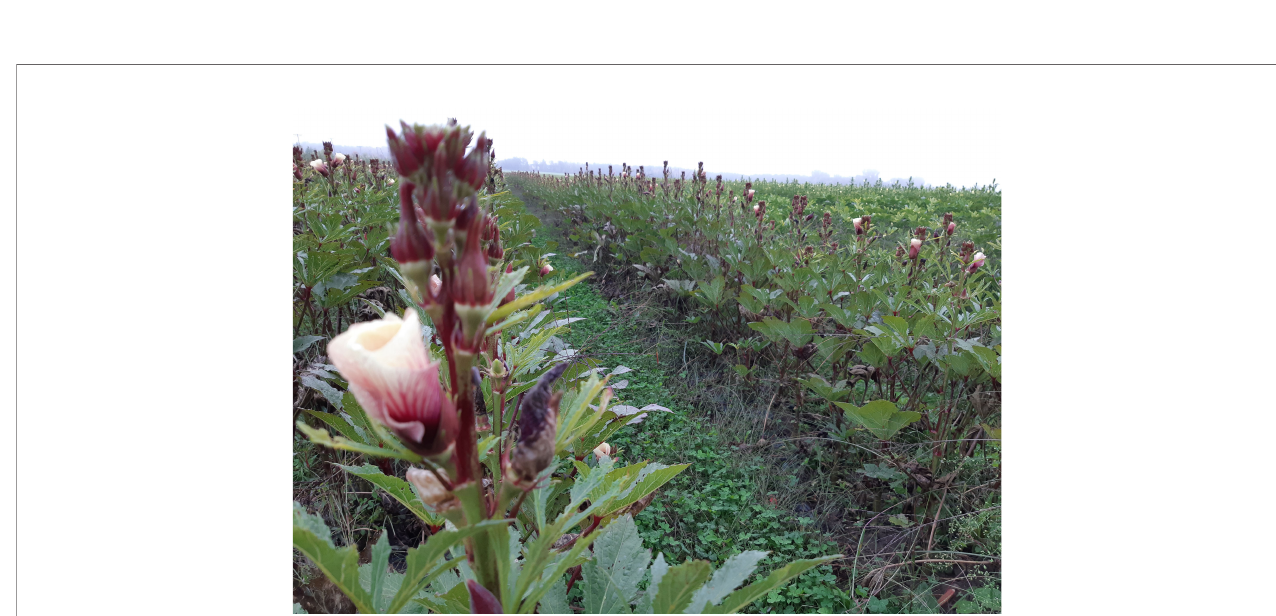
FIGURE 3 | Field of okra intercropped with clover. Photo credit: Jacynthe Dessureault-Rompre ́